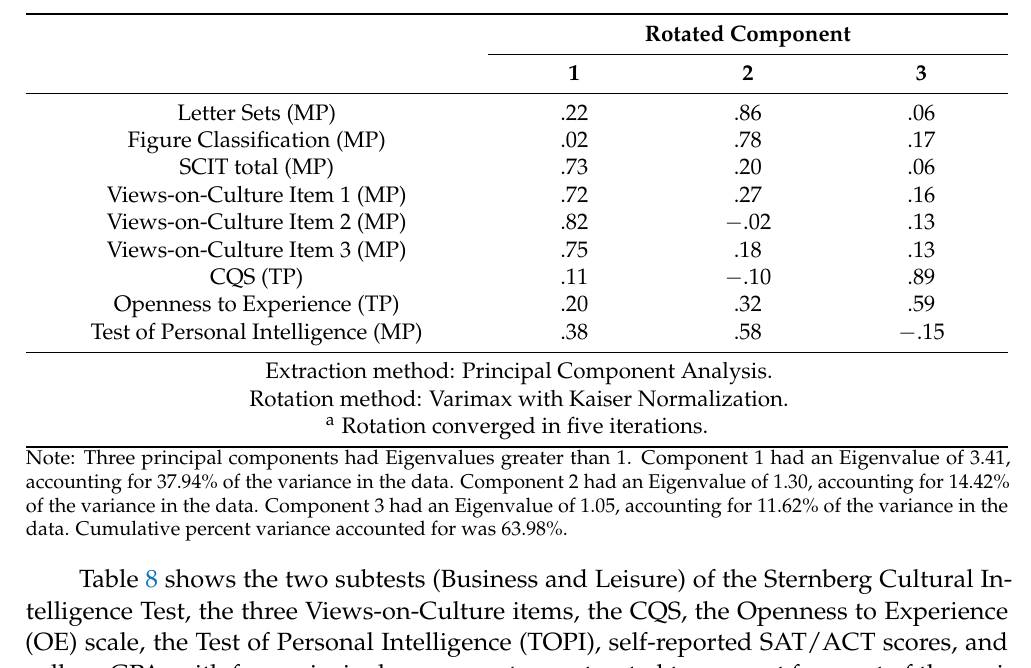
Table 7. Rotated Principal Components Matrix a : Psychometric assessments, SCIT Total with Psycho- metric Tests, VC, CQS, OE, and TOPI.